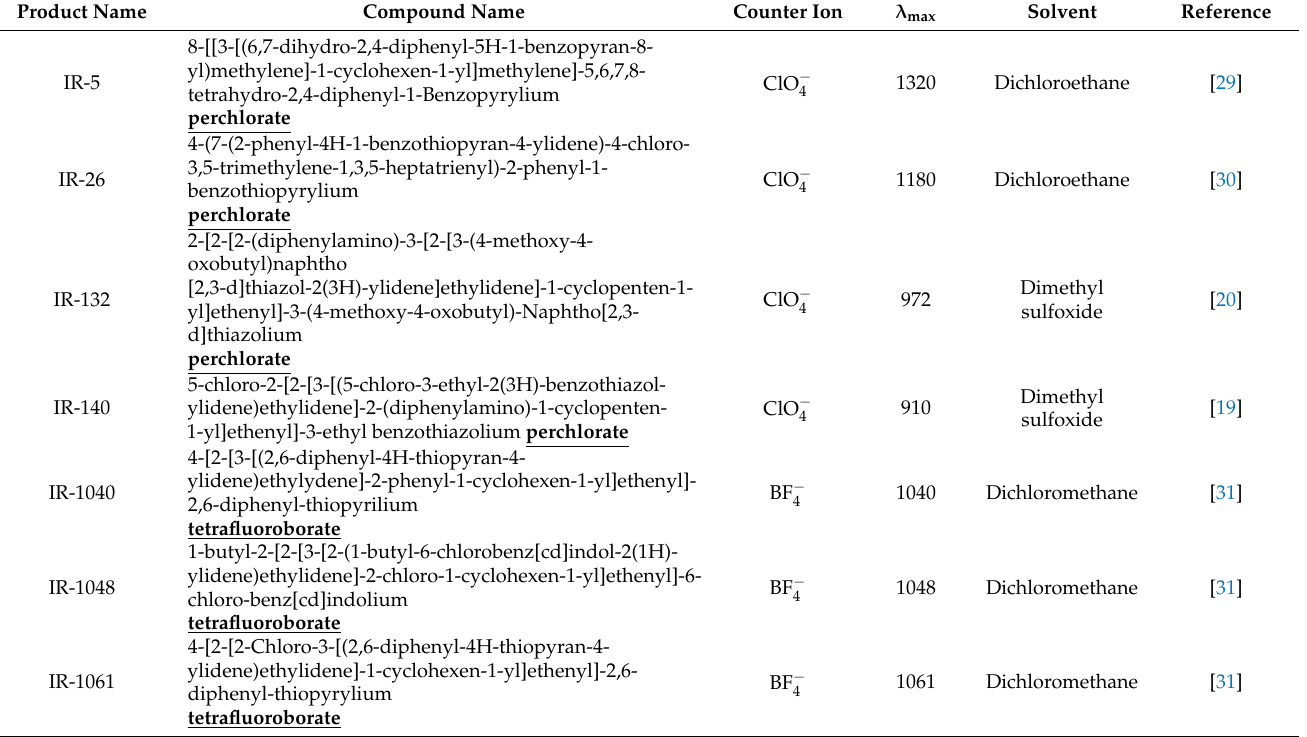
Table 1. Properties of NIR laser dyes coordinated with a counter ion. The counter ions are emphasized in the compound